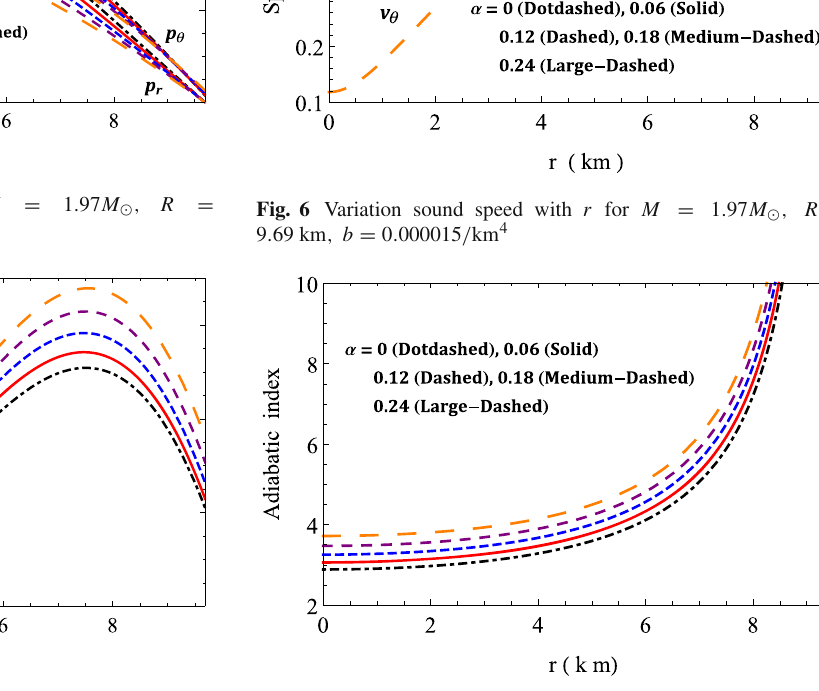
Fig. 4 Variation pressure anisotropy with r for M = 1 . 97 M (cid:3) , R = 9 . 69 km , b = 0 . 000015 / km 4